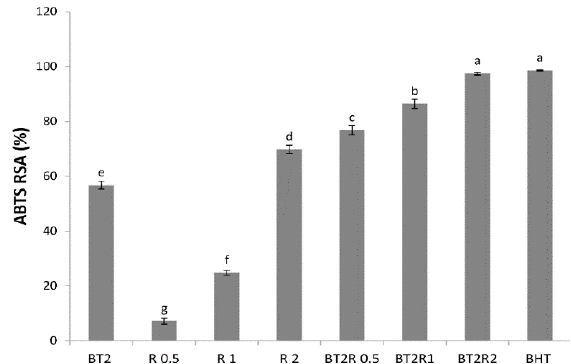
Fig. 4. ABTS Radical Scavenging Activity of Black Tea, R. damascena, and their infusions (Small letters show significant differences [P<0.05] among the ABTS scavenging activity of the samples; BHT (2 mg/ml) as the positive